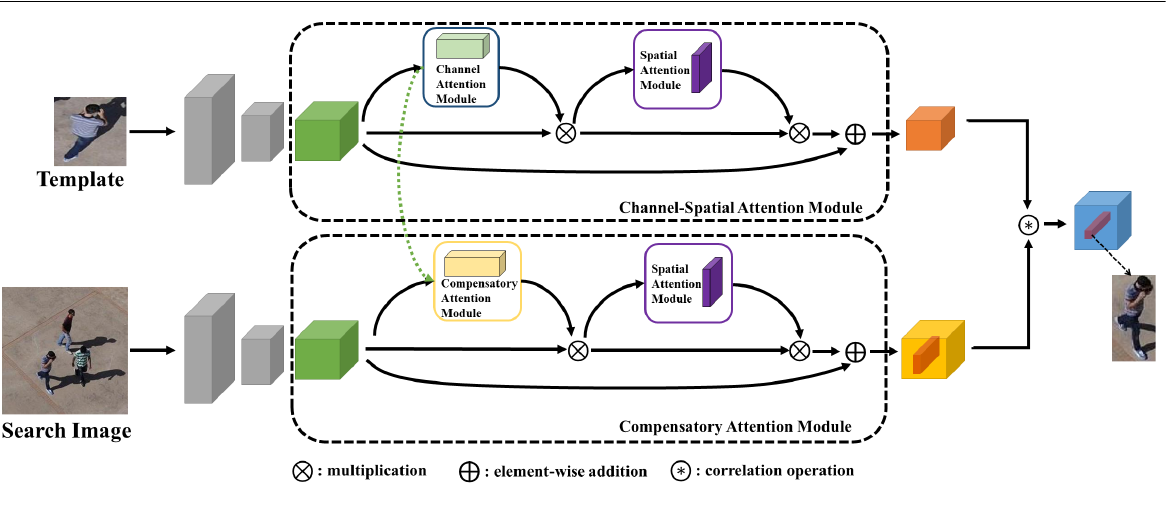
Figure 2. The architecture of our approach. On the template branch, the channel-spatial attention module is the same as the CBAM module. The pale green part is the channel attention matrix, and the purple is the spatial attention matrix. On the search branch, the pale yellow is our compensatory attention matrix, and the purple is likewise spatial attention